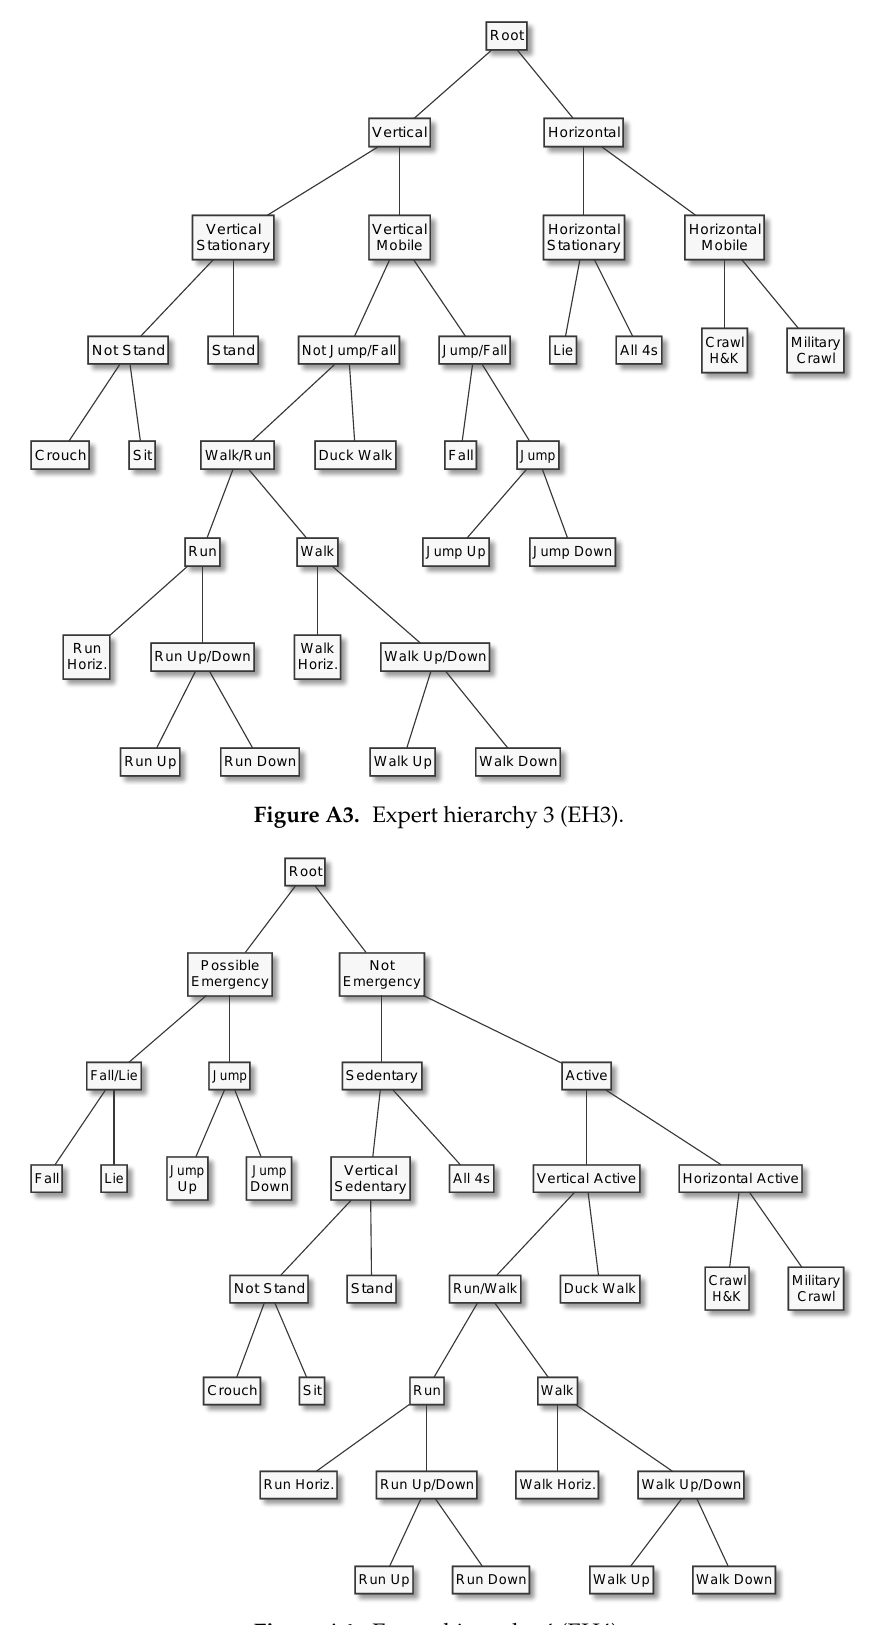
Figure A4. Expert hierarchy 4